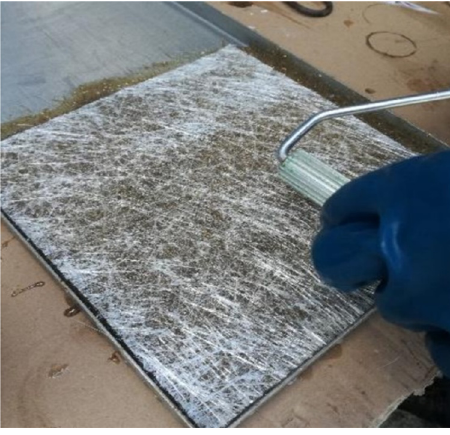
Figure 2: Manual production of polyester –